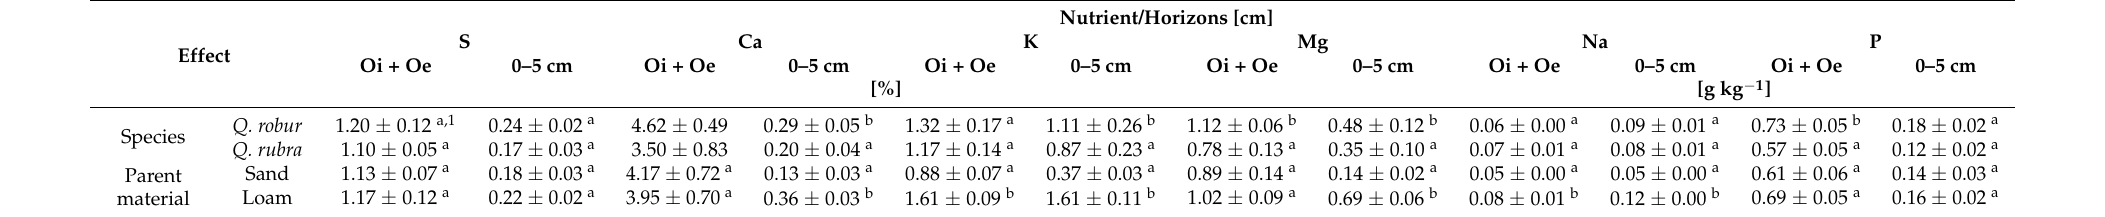
Table 2. Nutrient (S, Ca, K, Mg, Na, and P) content in reforested post-fire soils under common and red oak